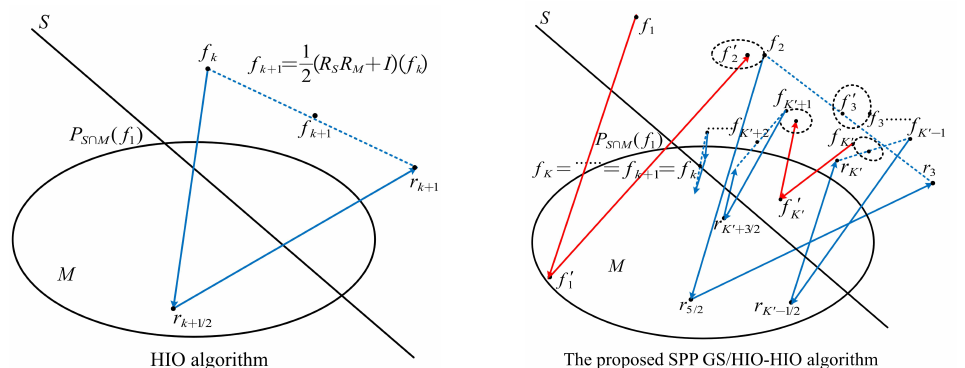
Figure 6. Schematic diagram of signal projection update under the constraints of HIO algorithm and the proposed algorithm.